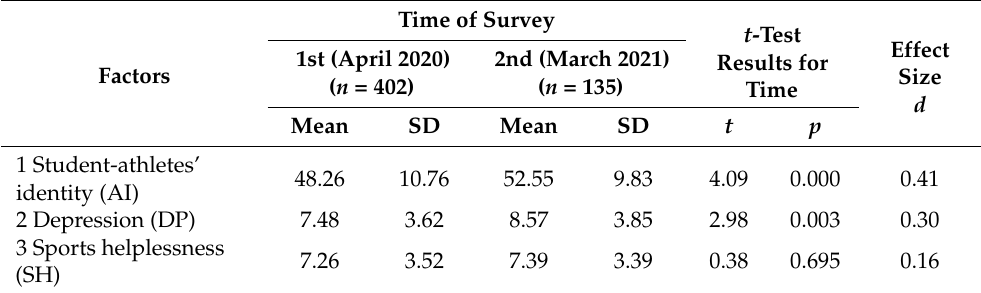
Table 5. Results of comparison in student-athletes’ identity and mental health status between the first and second time of the COVID-19 emergency declaration. Time of Survey t Factors